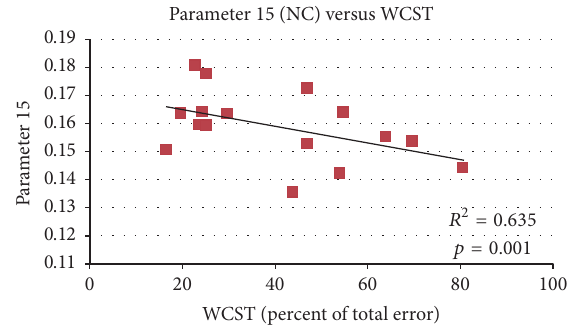
Figure 4: Regression analysis between loading parameters 15 (NC) and the percentages of total error on the WCST. 𝑅 square value is 0.635; the result was more significant in normal controls than in patients.